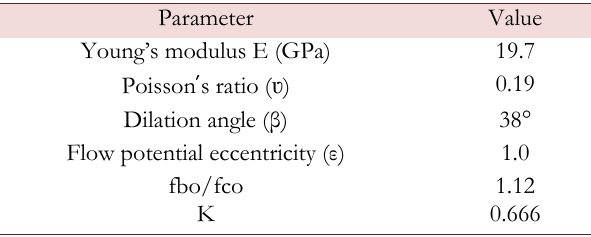
Table 2: concrete parameters.